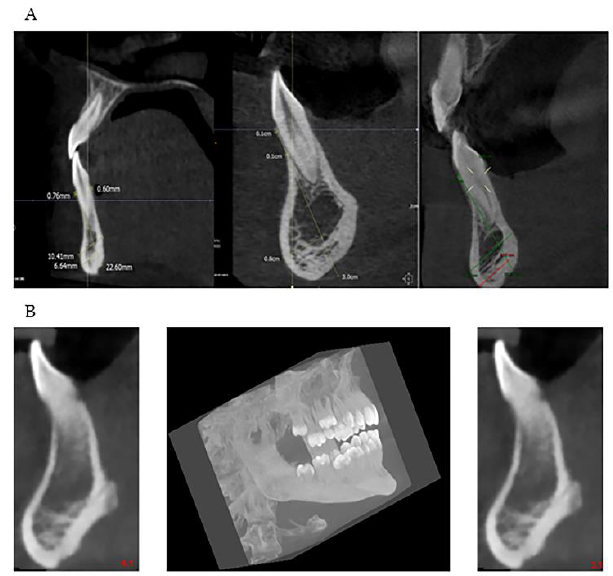
Figure 8. ( A , B ): Vestibular and lingual cortical reduction in zones 3.1 and 4.1 in patients with OI in the moderate-severe form. In the lower line of the Images ( B ) in the middle, there is a three-dimensional CBCT reconstruction that shows the very evident chin typical of OI.